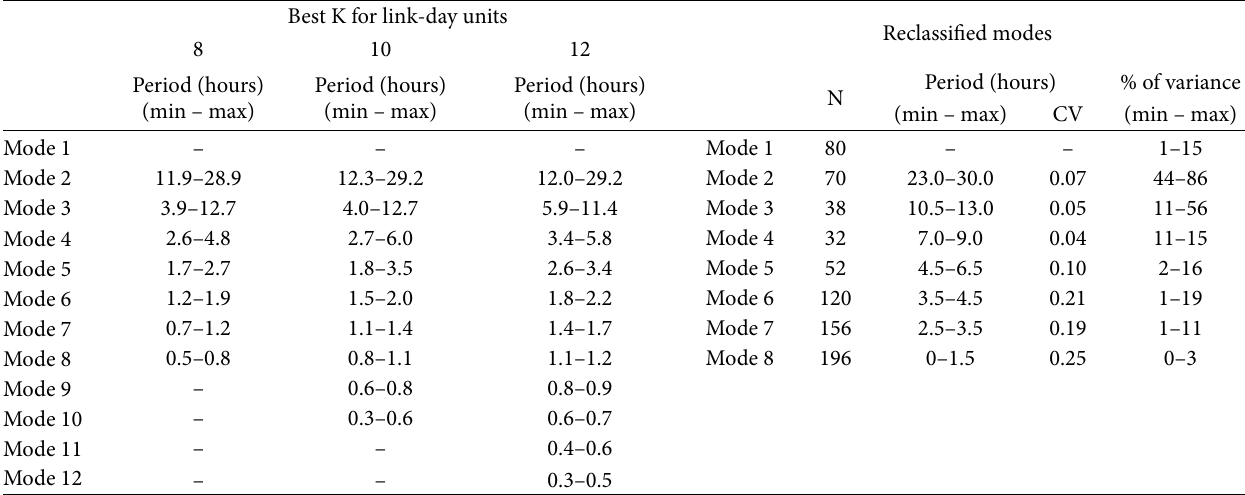
Table 2: Central period of modes of different K from speed data and reclassified modes with their spectral and statistical properties.